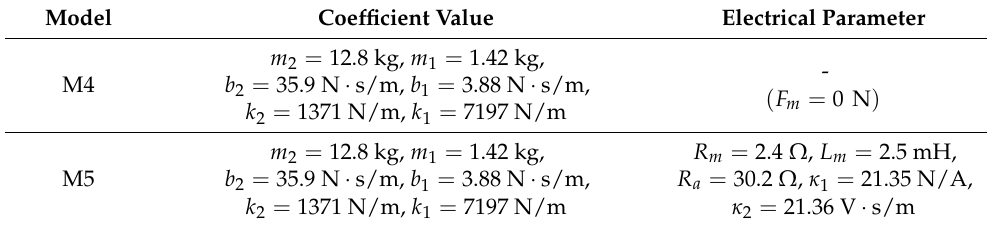
Table 2. Identified model